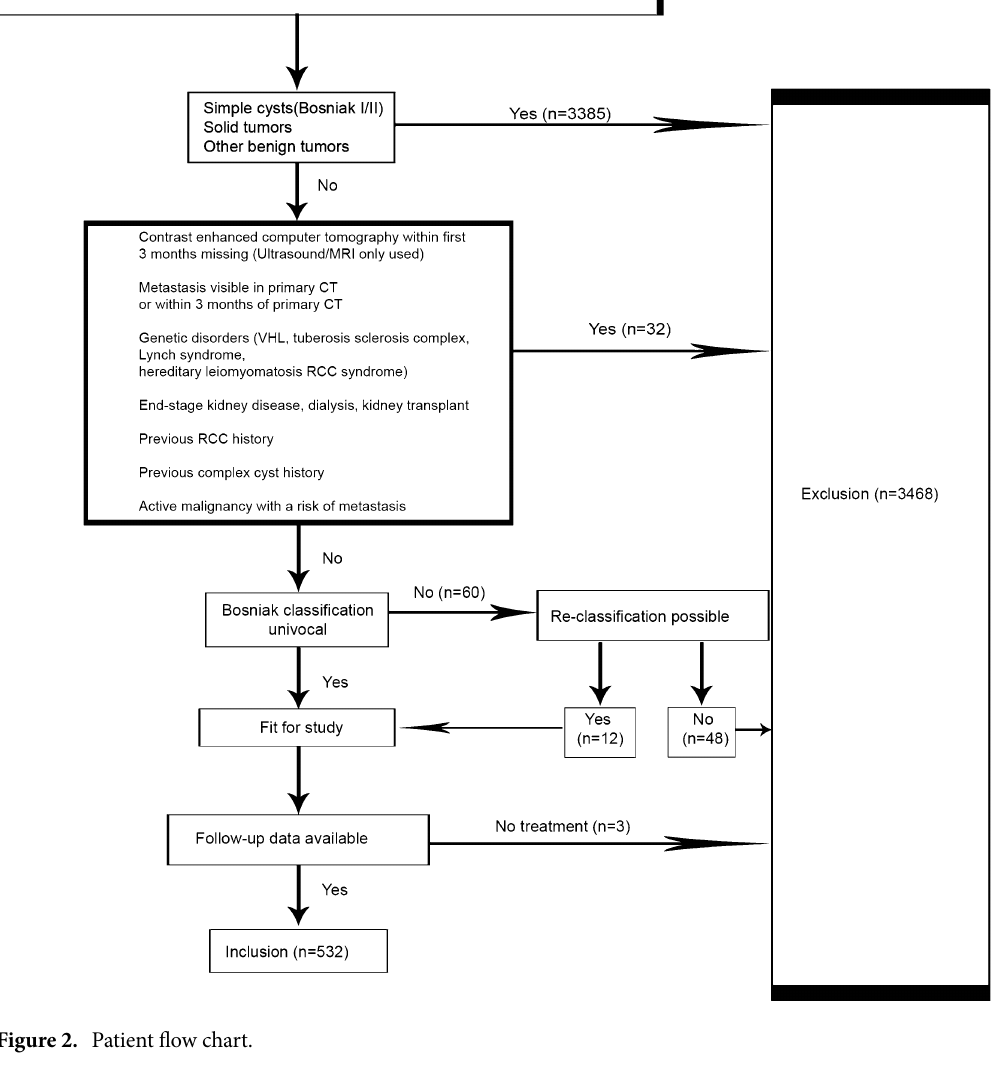
Figure 2. Patient flow